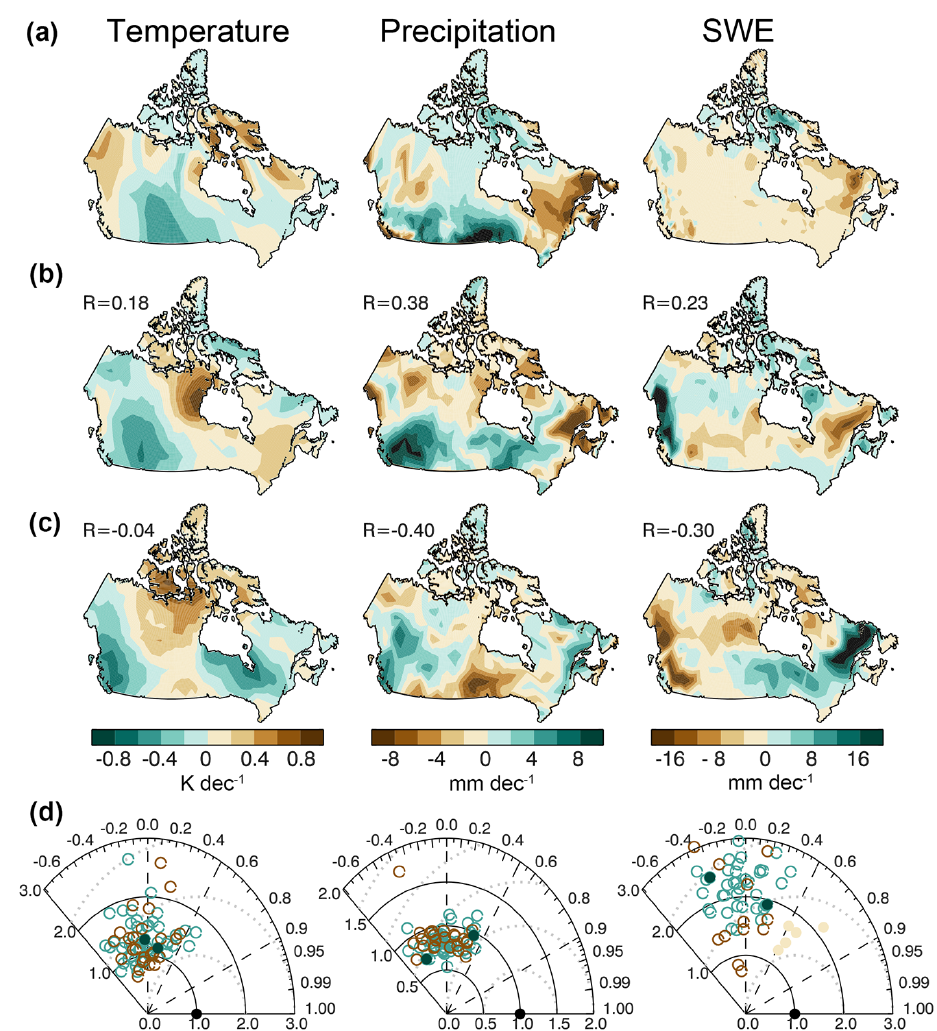
Figure 6. A similar analysis to Fig. 5 but for AMJ. Panels (a) and (d) represent AMJ trends, and (b) and (c) represent the same best match and worst match realizations from Fig. 5, but with AMJ trends